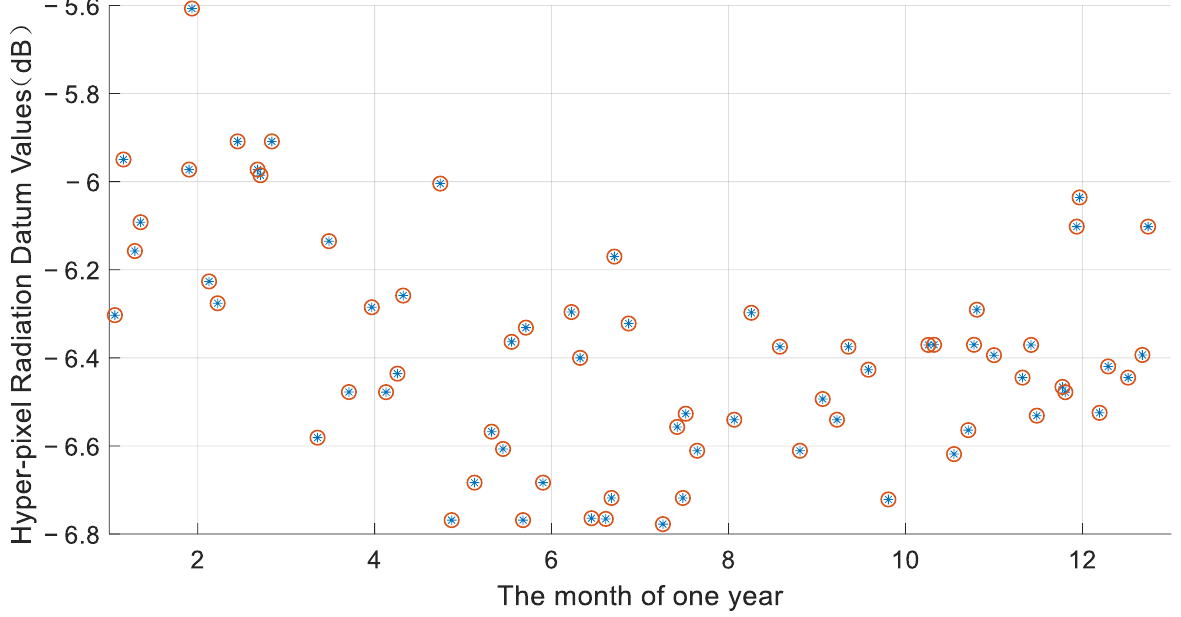
Figure 8. The Houston residential-hyper-pixel radiation-data values varied seasonally.